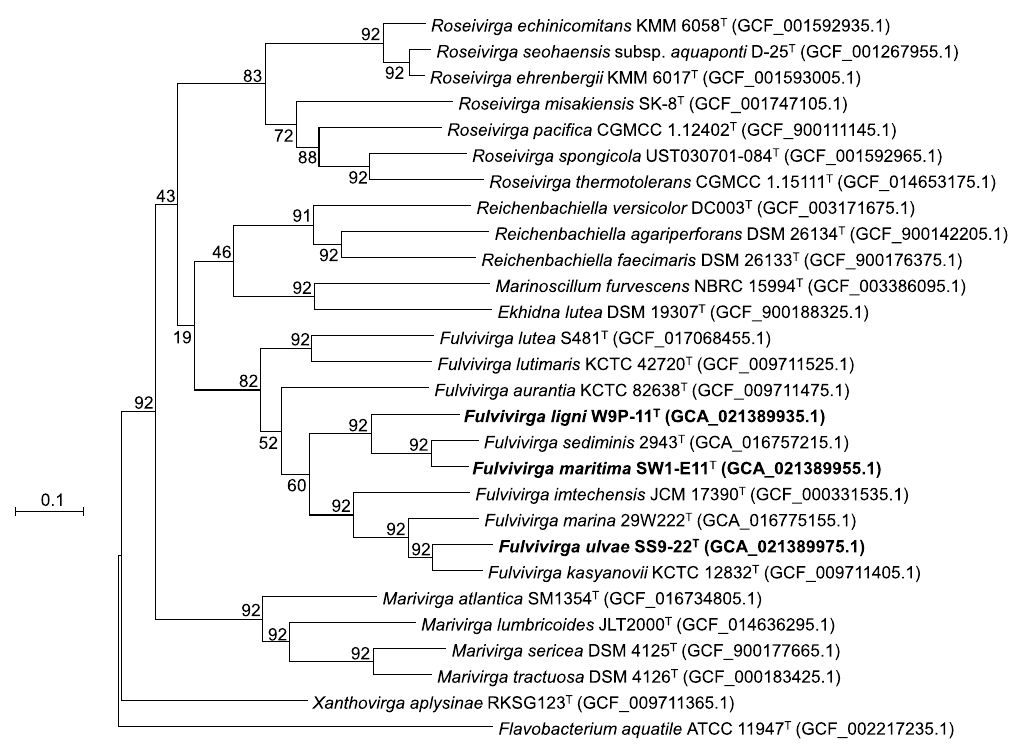
Figure 3. Maximum-likelihood phylogenetic tree showing relationship among SS9-22 T , W9P-11 T , and SW1- E11 T closely related species based on 92 core genes identified using the UBCG pipeline. GenBank accession numbers of the whole genome sequences are given in parentheses. Flavobacterium aquatile ATCC 11947 T (GCF_002217235) as the outgroup. Bootstrap values based on 1000 replicates are indicated at the branch nodes. Bar, 0.1 substitutions per